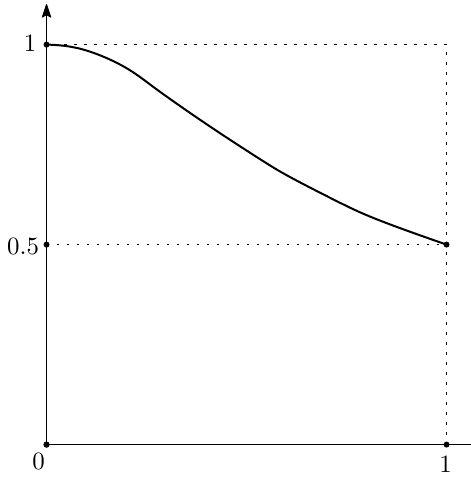
Fig. 2. Expectation of the inverse weight (as a function of b